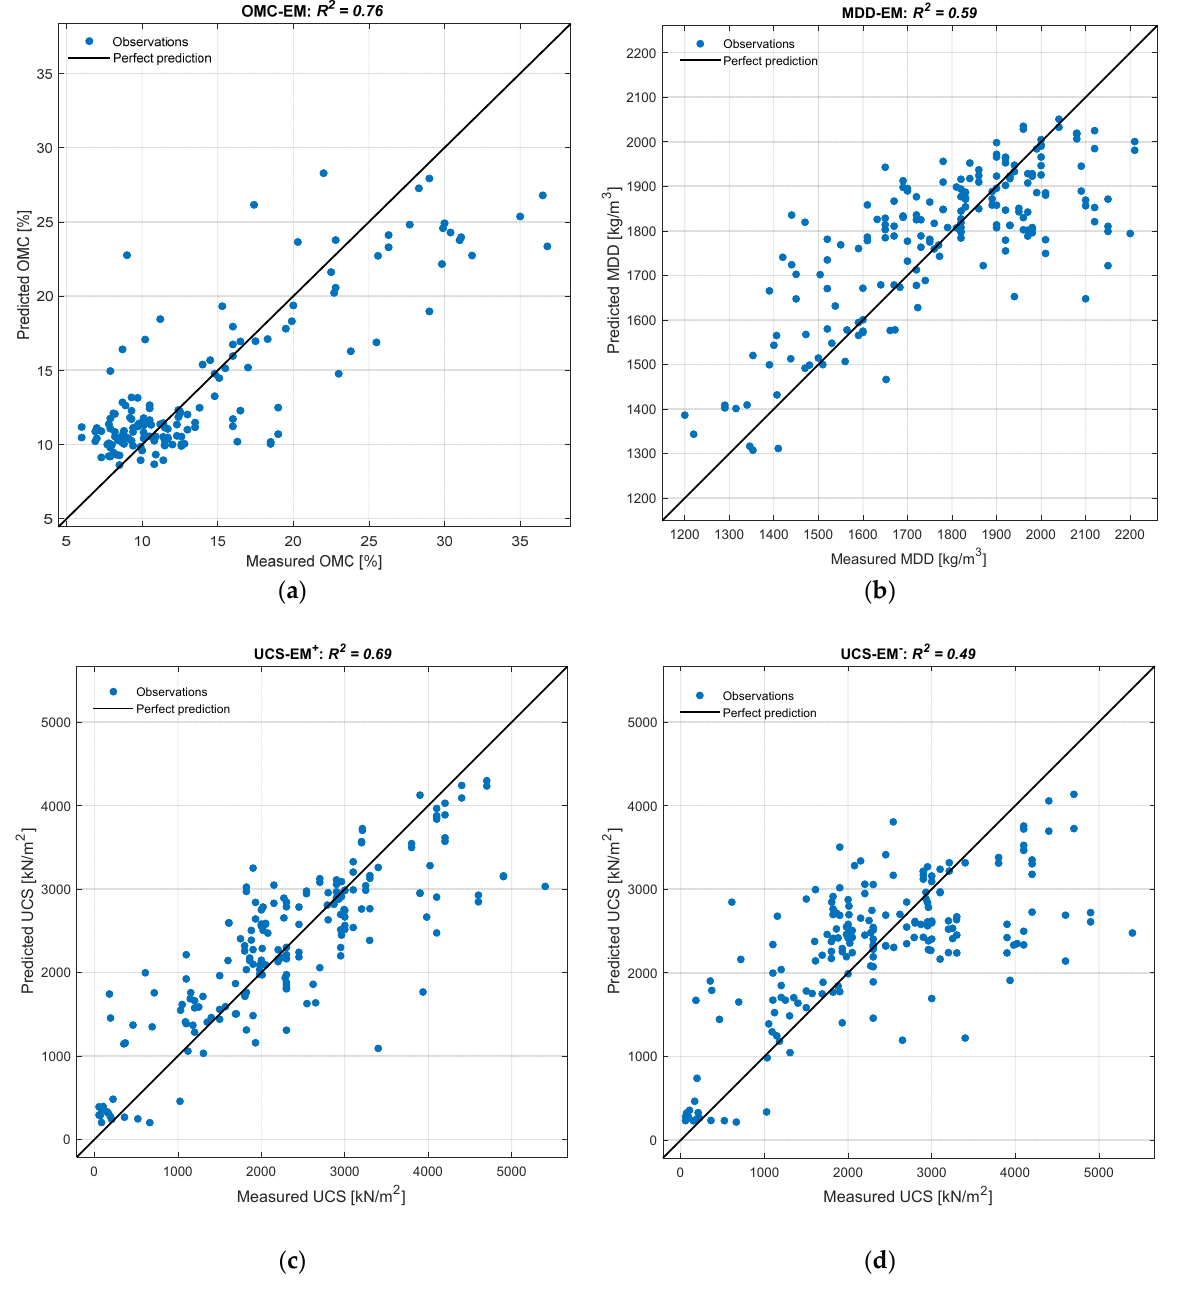
Figure 2. Regression plot and validation R-square scores of: ( a ) OMC-EM, ( b ) MDD-EM, ( c ) UCS-EM + and ( d ) UCS-EM − . Table 4. Statistical performance measurement of the developed models on unseen data and the optimized hyperparameters.